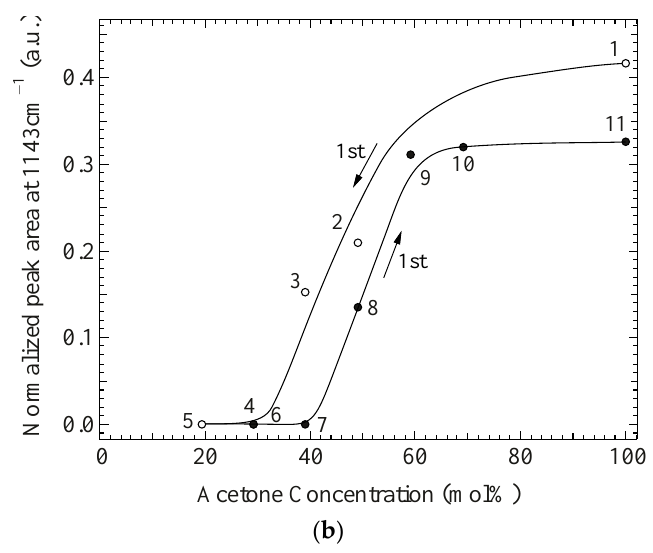
Figure 4. ( a ) ATR FT/IR spectra of a chemically crosslinked and dehydrated gel in various DMSO/acetone mixtures during the single-sample test shown in Figure 3. The detailed changes at around 3300 cm − 1 (region [A]) and 1143 cm − 1 (region [B]) are displayed; ( b ) The peak area at 1143 cm − 1 normalized by the peak area at ca. 1427 cm − 1 , obtained by deconvoluting the spectra to remove the effects of other peaks. The respective number from 1 to 11 corresponds to those in Figure 3. The acetone concentrations are as follows; No. 1: 100, No. 2: 50, No. 3: 40, No. 4: 30, No. 5: 20, No. 6: 30,